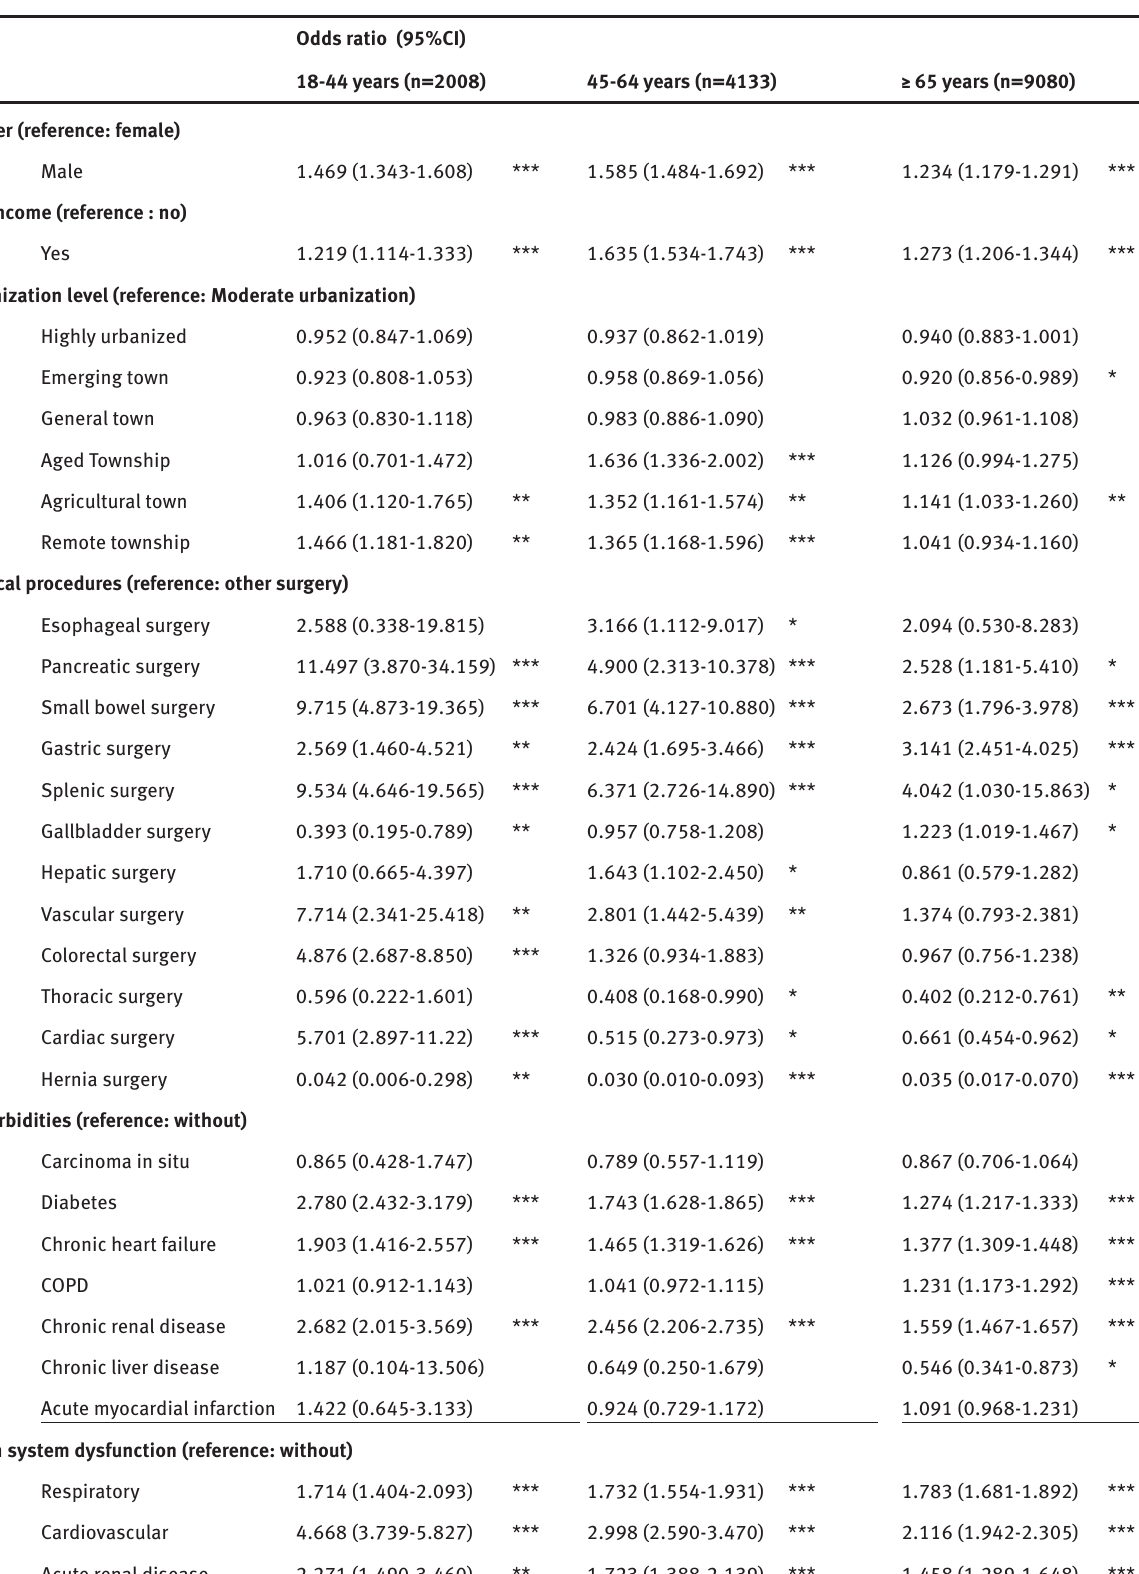
Table 3: Odds ratio and 95% confidence interval of surgery among patients with sepsis in each of the predefined age